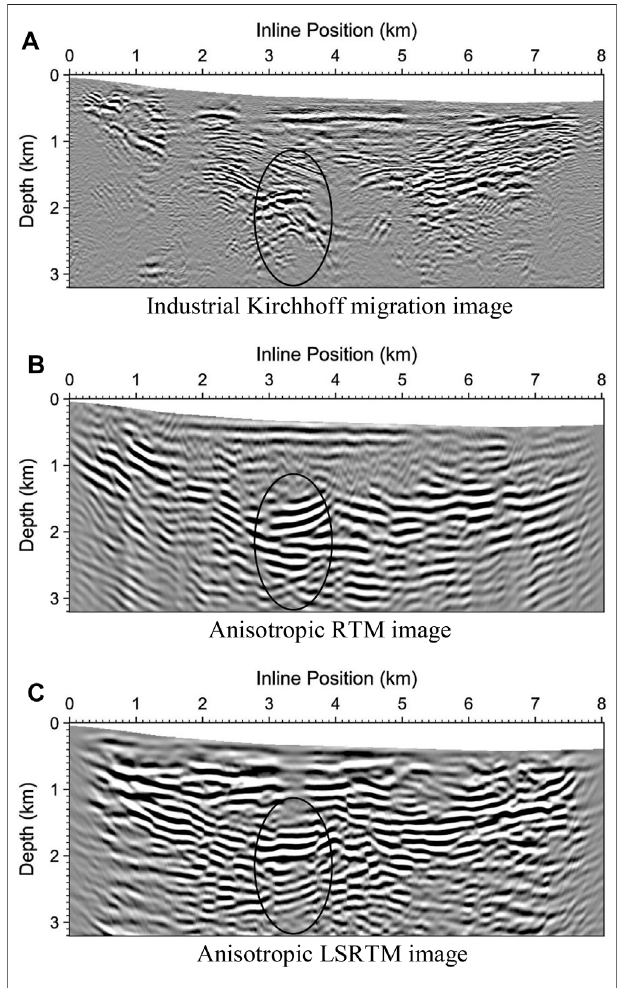
FIGURE 10 | Subsurface migration images of Line 1 at Pirouette Mountain produced using various migration methods: (A) Industrial Kirchhoff migration, (B) Anisotropic RTM, (C) Anisotropic LSRTM. Two nearly-vertical faults can be clearly identi fi ed within the ellipse region in (C) .